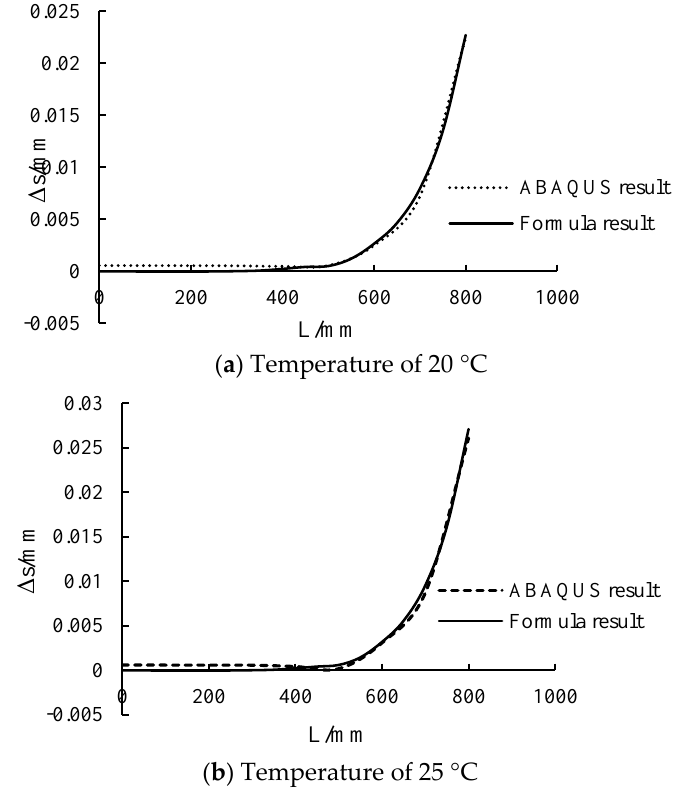
Figure 6. Strain distribution at a temperature of 25 °C.